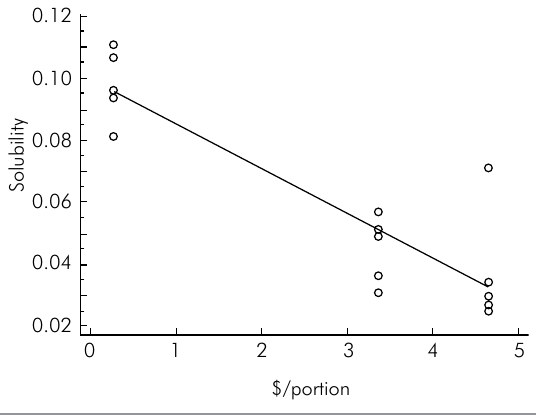
Figure 4. Linear regression: cost versus μSBS in dentin.